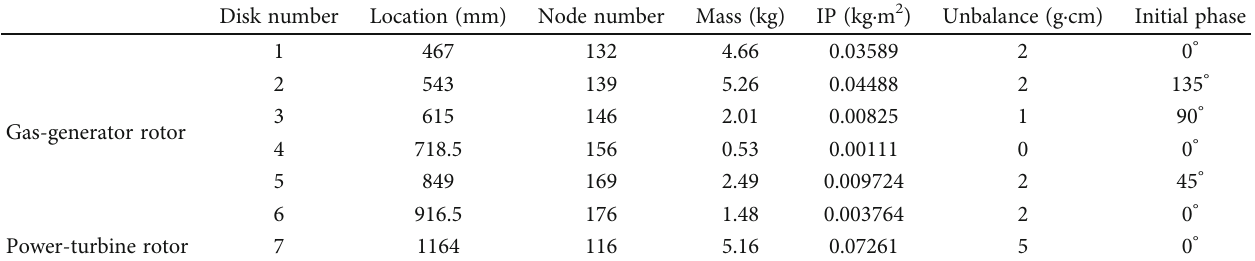
Table 1: Parameters of disks.